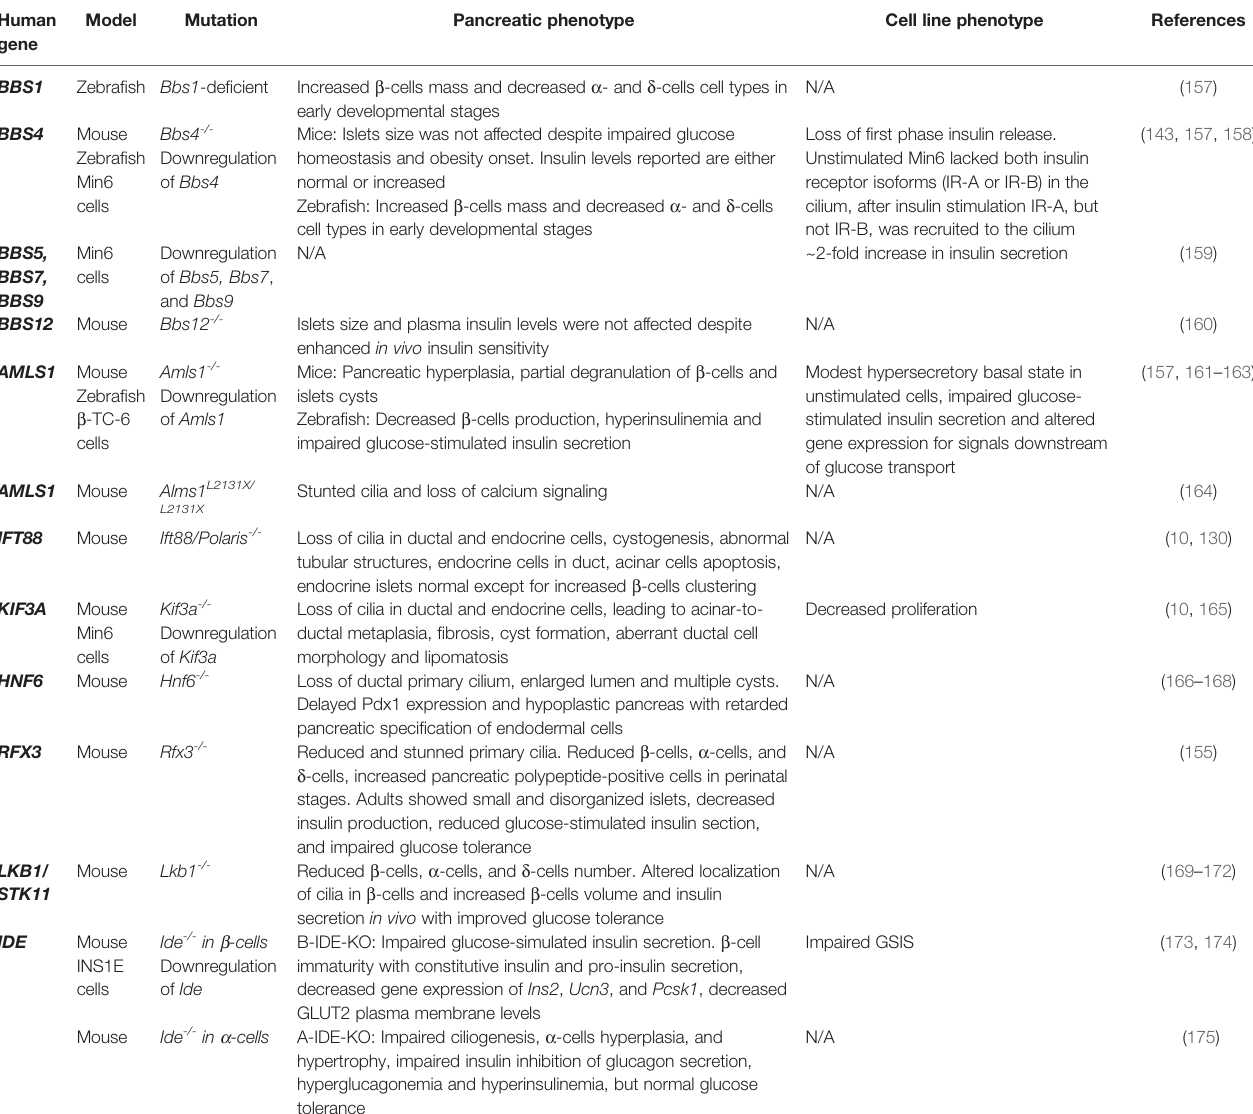
TABLE 2 | Mutations in genes related to cilia and their phenotypes in several cellular and animal models. Human